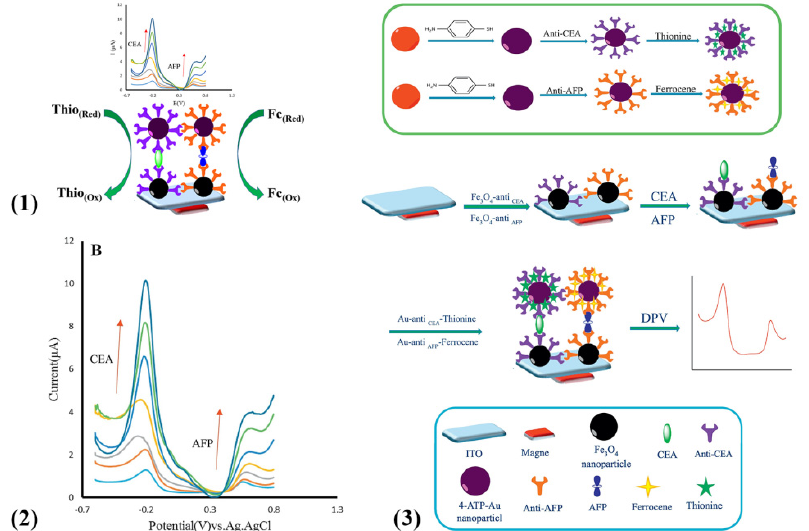
Figure 1. ( 1 ) Sandwich-type electrochemical immunosensor for the simultaneous detection of CEA and AFP. ( 2 ) DPV responses of the immunosensor incubated with a series of different concentrations of CEA and AFP. ( 3 ) Assembly schematic of electrochemical immunosensor for the detection of CEA and AFP (reprinted with permission from Ref. [54], Copyright 2018, Elsevier).